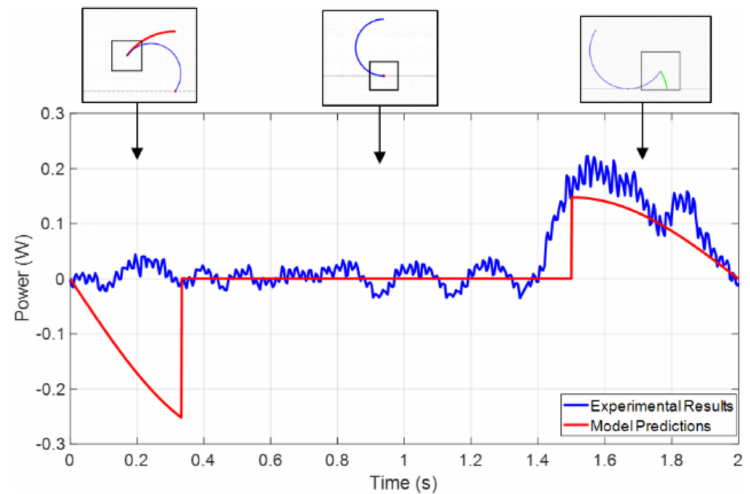
Figure 18. Power consumption associated with the rate of change of kinetic energy (KE), and gravitational potential energy (GPE) of the